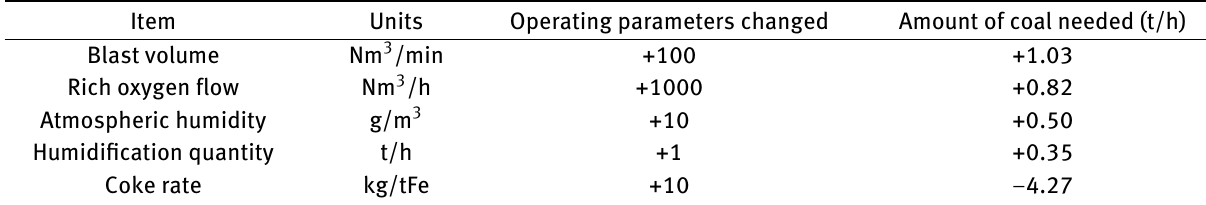
Table 3: Amount of coal needed when the operating parameters of the blast furnace are changed.